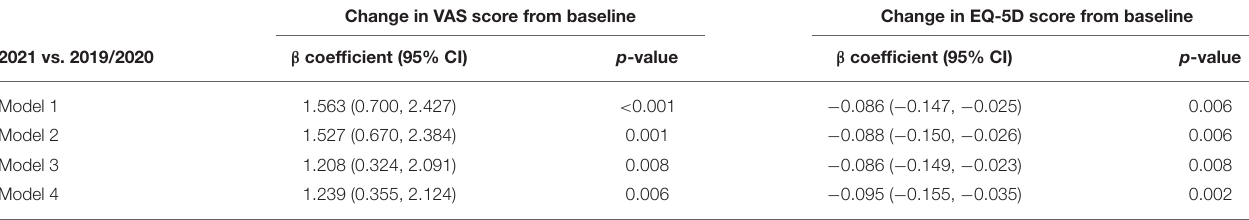
TABLE 5 | Associations between the COVID-19 pandemic in 2021 and changes from baseline to 1-month follow-up in VAS and EQ-5D scores. Change in VAS score from baseline Change in EQ-5D score from